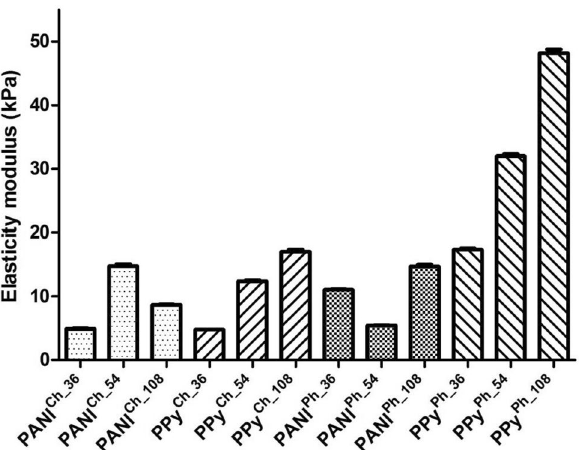
Figure 2. Elasticity moduli calculated for physically ( PH ) and chemically ( CH ) crosslinked scaffolds. The experiments were performed in compression mode and the relative standard deviation of all values obtained did not exceed